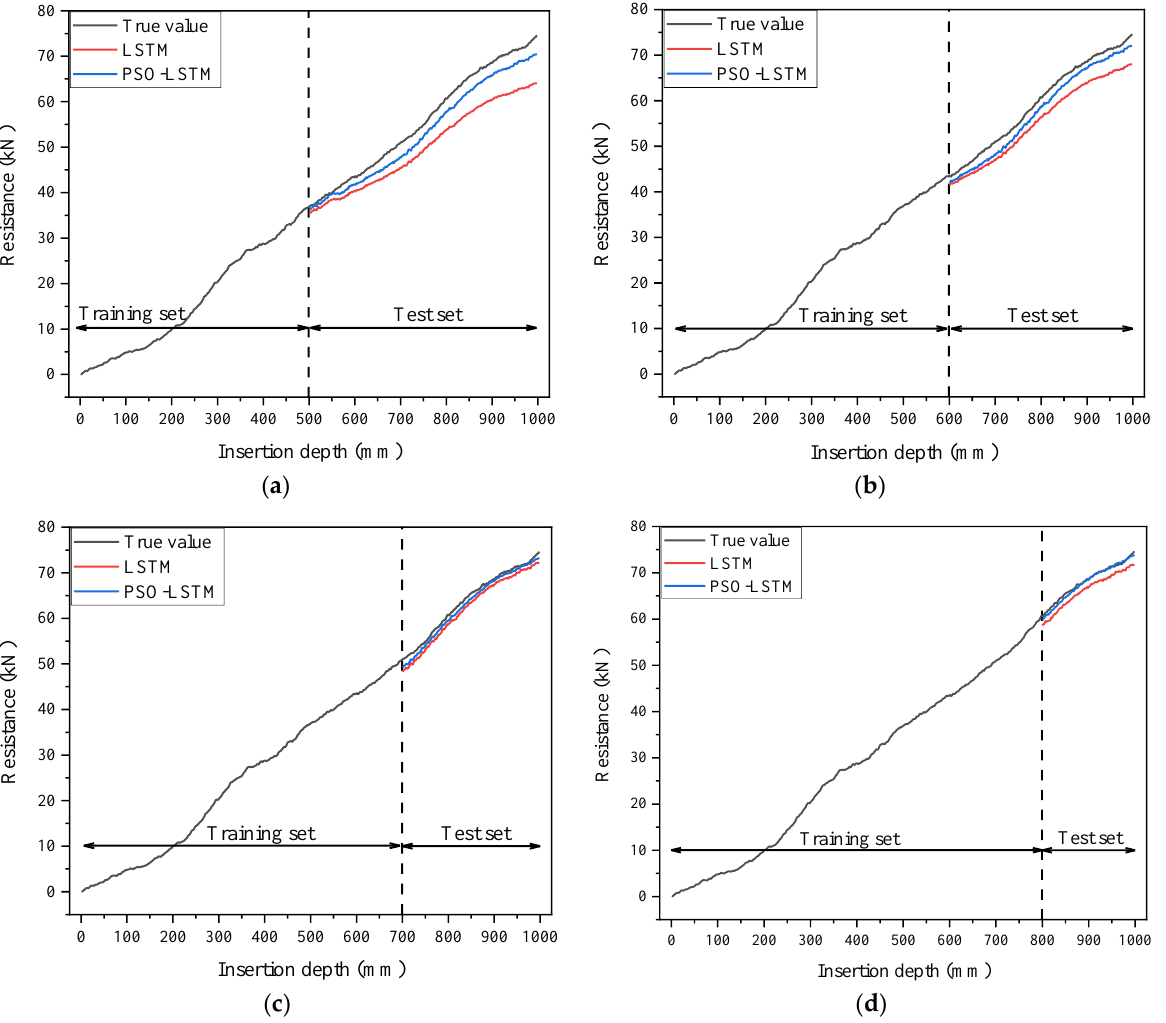
Figure 22. Sand samples with an insertion depth of 1000 mm. ( a ) The training set proportion of 50%; ( b ) The training set proportion of 60%; ( c ) The training set proportion of 70%; ( d ) The training set proportion of 80%.